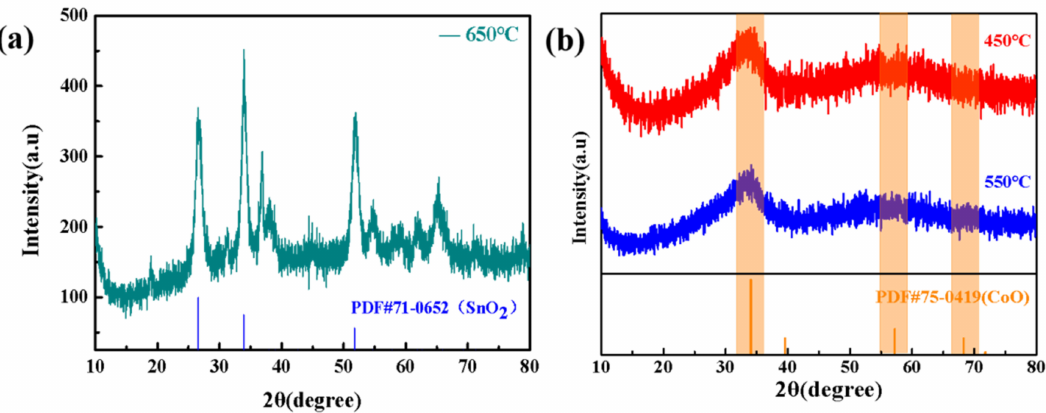
Figure 6. ( a ) XRD patterns of Co 3 Sn 2 S 2 nanocrystals at different annealing temperatures of 450 ◦ C and 550 ◦ C; ( b ) XRD patterns of Co 3 Sn 2 S 2 nanocrystals at 650 ◦ C.